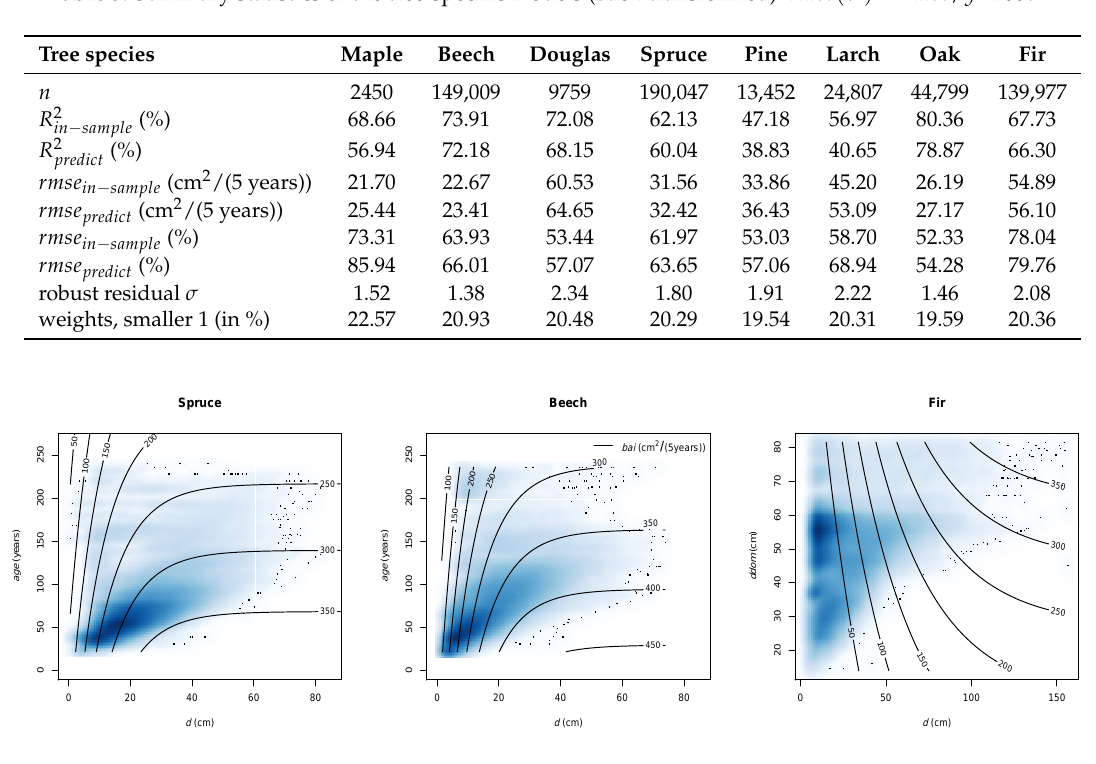
Table 3. Summary statistics of the tree-specific models (back-transformed). rmse ( % ) = rmse / ¯ y · 100%.